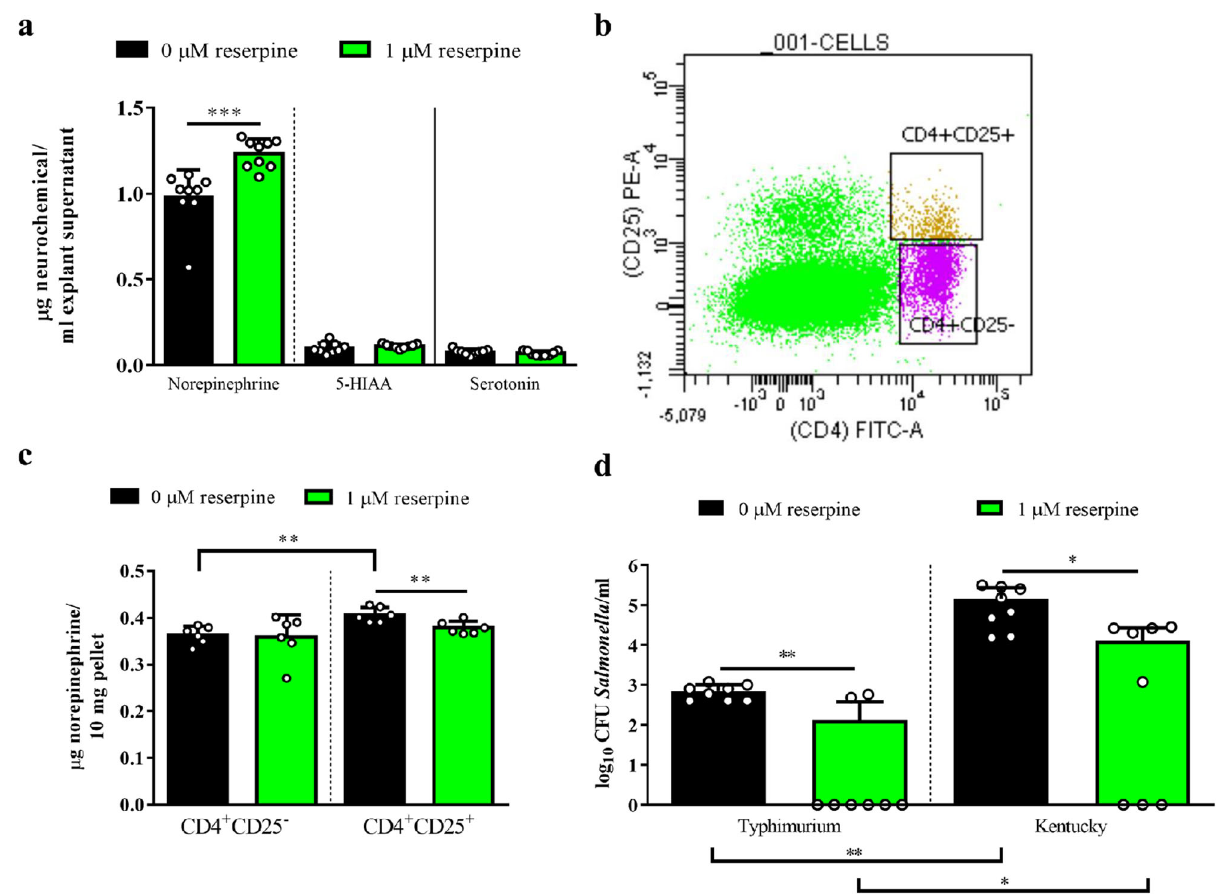
Fig. 1 Intracellular norepinephrine release by reserpine increased Salmonella resistance ex vivo. Neurochemical release from explants ( a ) and sorted T cells ( b, c ) was evaluated via UHPLC. Reserpine treatment (1 µ M) increased bactericidal responses against Salmonella in explants ( d ) regardless of serovar. Signi fi cant differences indicated by asterisks: * P < 0.05; ** P < 0.01; *** P < 0.001. Error bars indicate the standard deviation above and below the